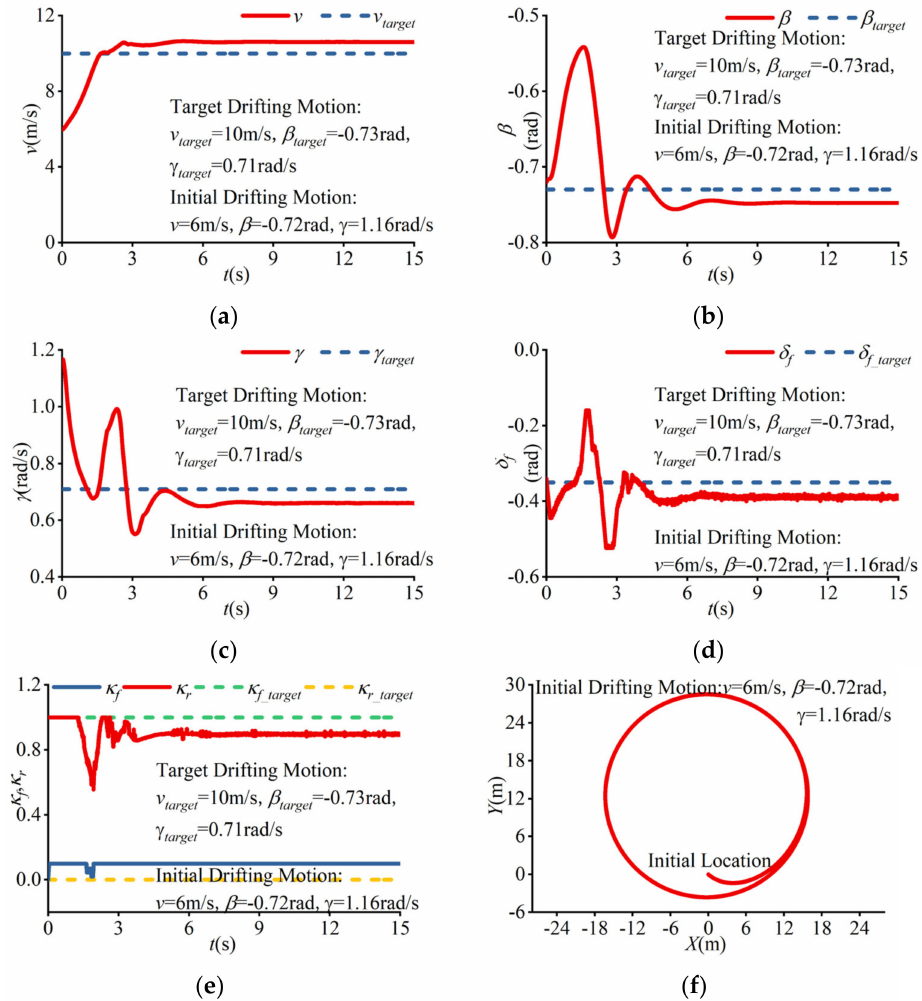
Figure 11. The simulation result with the initial drifting motion as Group 5 in Table 3 to realize the target drifting motion as Group 2 in Table 2: ( a ) the variation curve of the velocity; ( b ) the variation cure of the sideslip angle; ( c ) the variation curve of the yaw rate; ( d ) the variation cure of the steering angle; ( e ) the variation curves of the TYDEX longitudinal slip ratios; ( f ) the position modification of the narrow tilting vehicle in the ground